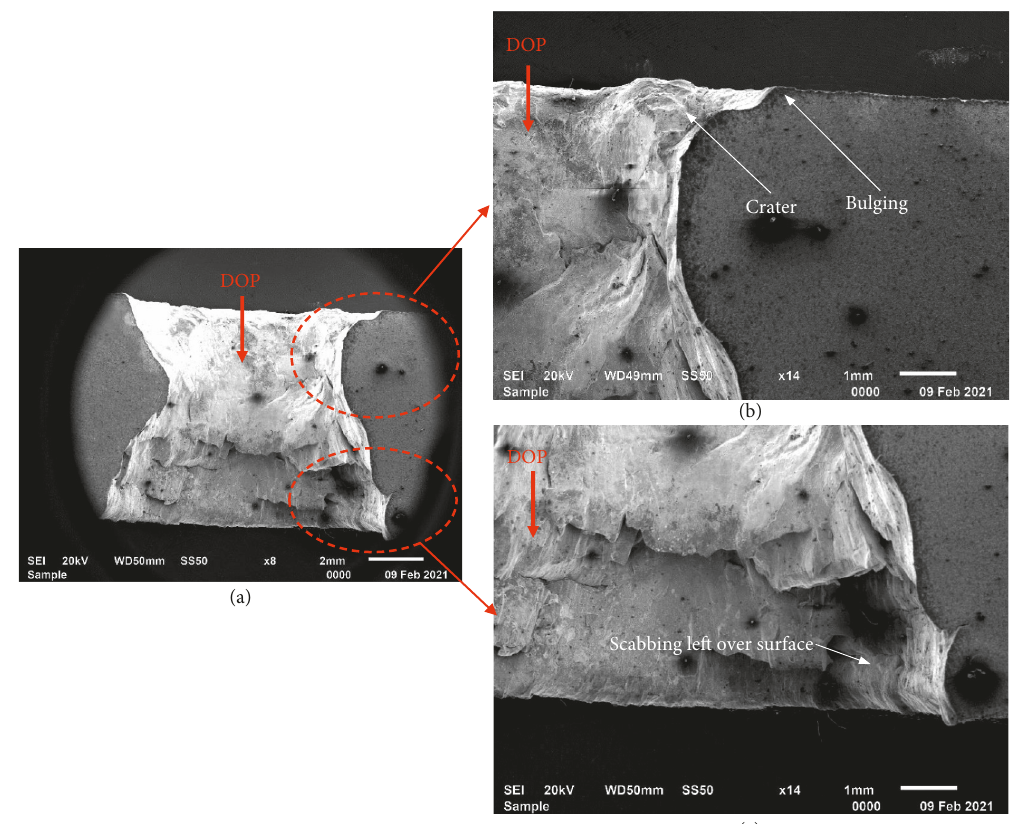
Figure 9: SEM SEI micrographs (a) of the penetration hole through an 8 mm thick plate and (b and c) higher magnification micrographs at the circled areas on the edge of the entry and exit points of the projectile hole in (a), respectively.